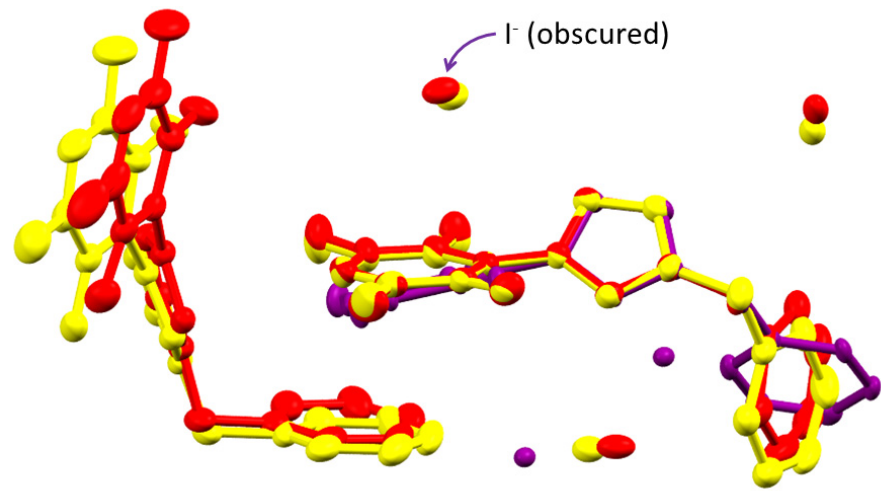
Figure 3. Overlay of the structures of the cations of 1-(2,3,5,6-tetrafluoro-4-pyridyl)-3-benzylimidazolium chloride ( 1 ) (yellow), bromide ( 2 ) (red) and iodide ( 3 ) (purple) with their three closest anions and cations involved in π ··· π stacking with the tetrafluoropyridyl ring. Thermal ellipsoids are at the 50% level. Hydrogen atoms are omitted for clarity.